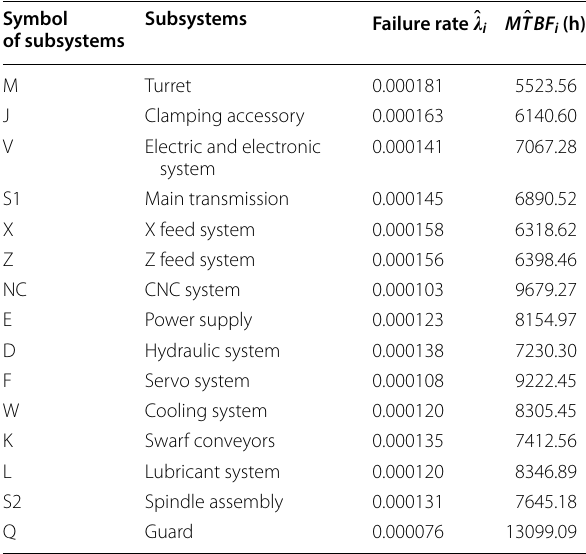
Table 2 Allocation results according to the method proposed in Ref.